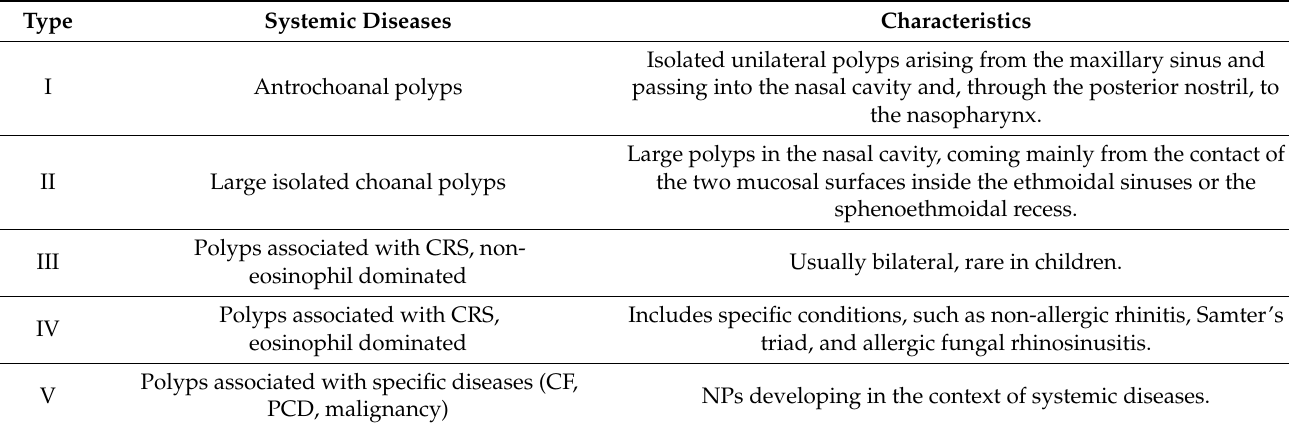
Table 1. Stammberger’s classification of nasal